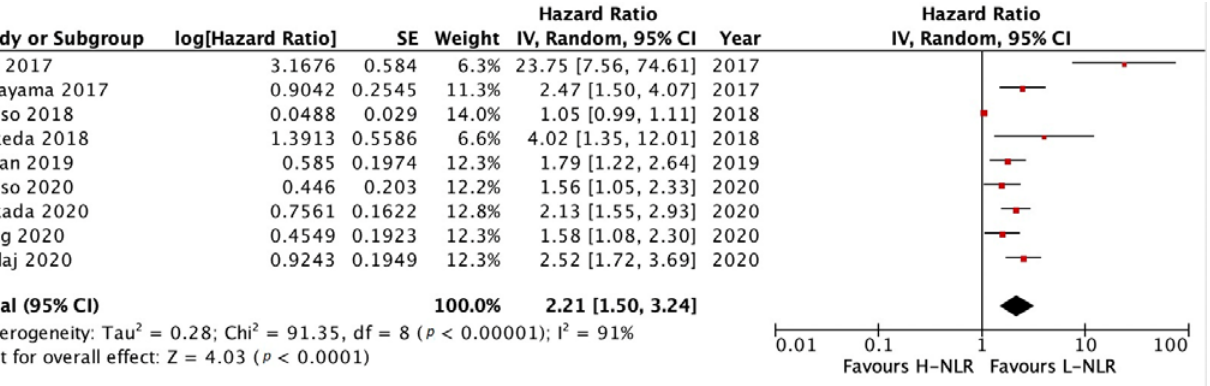
Figure 2. Forest plot H-NLR versus L-NLR to PFS in patients treated with immunotherapy. Red dots represent study weights; the bivalve represent the overall effect.